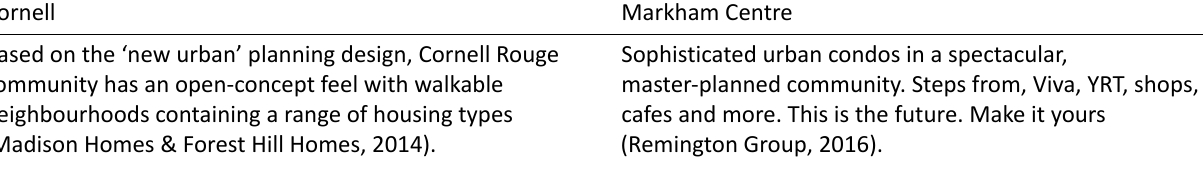
Table 3. Cornell and Markham Centre housing advertisement discourse examples. Cornell Markham